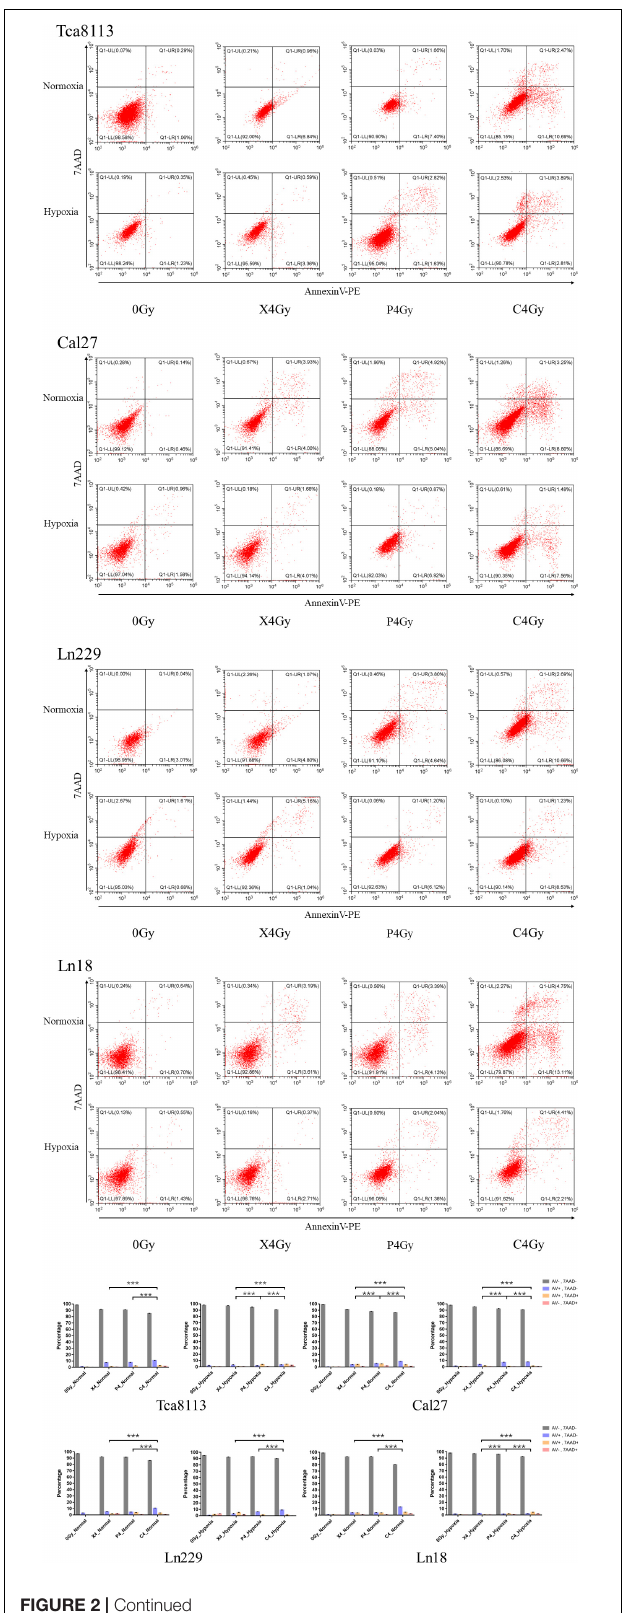
FIGURE 2 | Comparison between the percentage of viable and dead cells under normoxia and hypoxia. Tumor cells in normoxic and hypoxic conditions were exposed to 4Gy physical dose photon, proton, or carbon-ion radiation. Cell survival was detected 48 h after irradiation using the Annexin V/7-AAD double staining kit. Representative flow cytometry images for each group are shown in the scatter plots. Statistical analysis of the cell survival and death percentages for each group are shown in the histograms. Each experiment was repeated at least three times. *** p < 0.001.